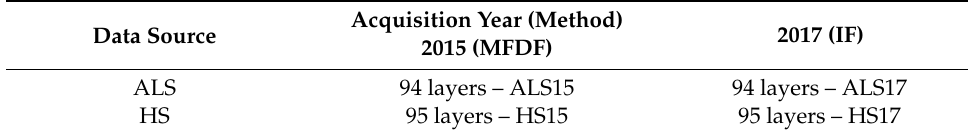
Table 3. Number of products broken down by source and data collection method. Abbreviations: HS—Hyperspectral; ALS—Aerial Laser Scanning.